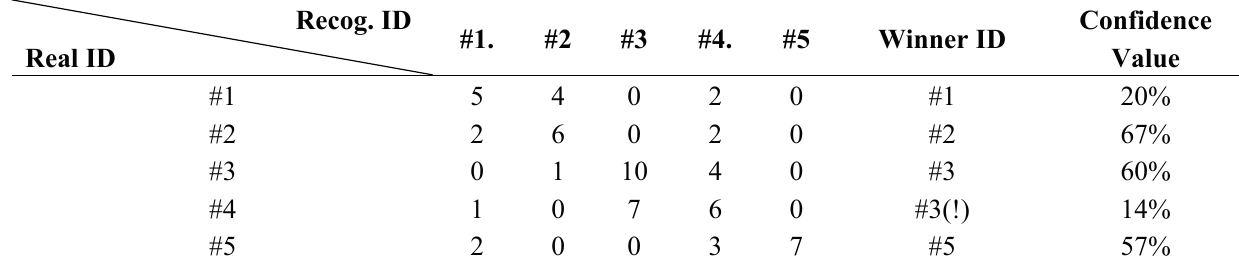
Table 4. Vote matrix of the proposed human identification solely based on Face.